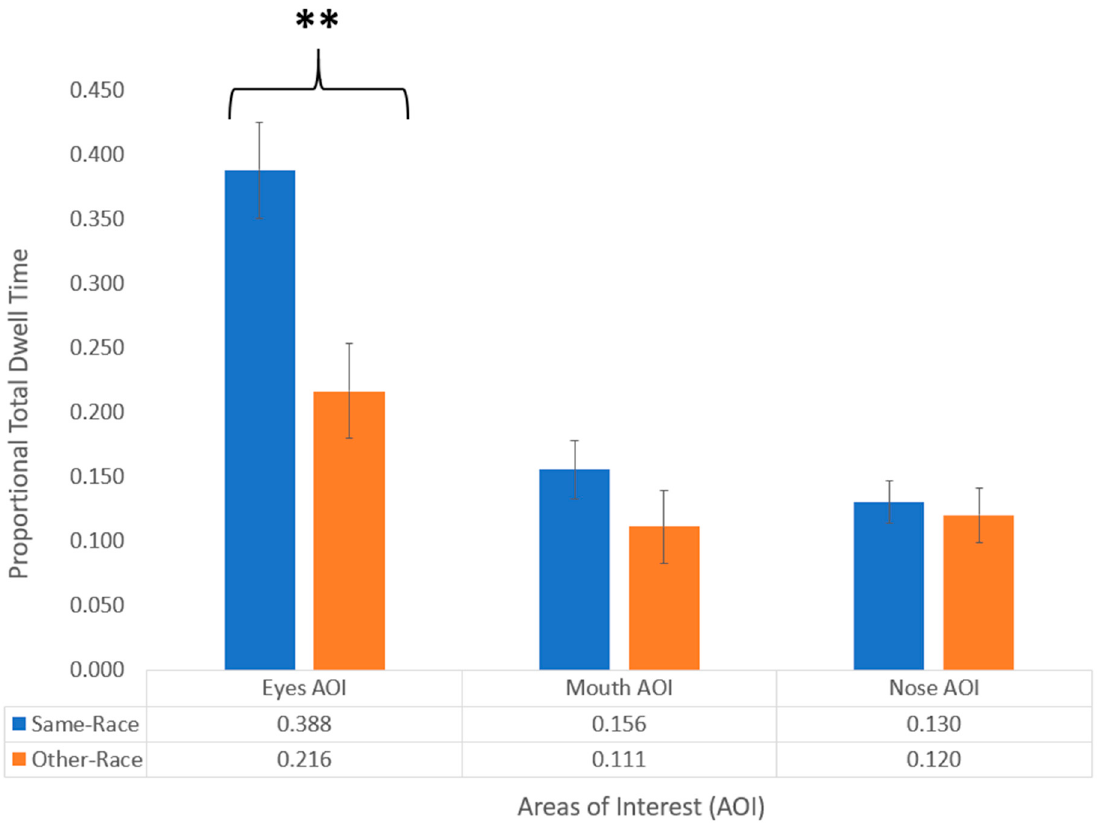
Figure 4. Proportional total dwell times for eyes, nose, and mouth AOIs during the habituation phase for the same-race and other-race conditions. Error bars indicate standard error, and the two stars indicate a significance level of p < 0.01.